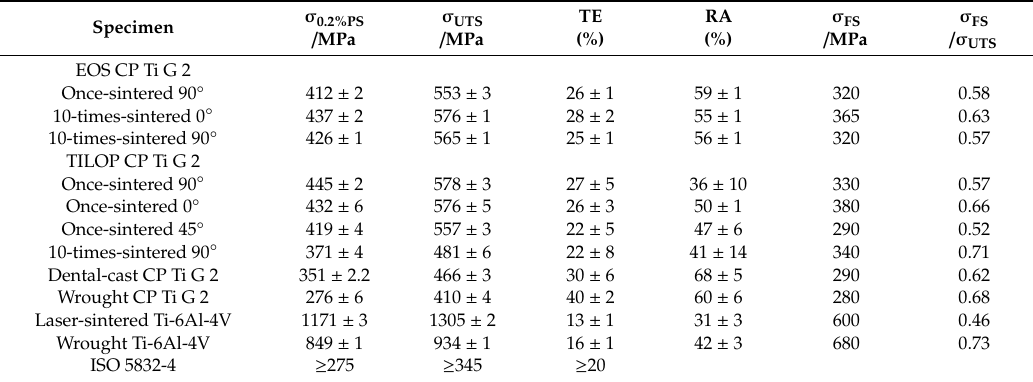
Figure 8. Effects of repeated laser sintering on mechanical properties ( σ 0.2% PS , σ UTS , TE, and RA) of laser-sintered EOS CP Ti G 2 rods. Table 2. Tensile properties ( σ 0.2%PS , σ UTS , TE, and RA), fatigue strength ( σ FS ), and fatigue ratio ( σ FS / σ UTS ) of CP Ti G 2 and Ti-6Al-4V alloys manufactured under various conditions.